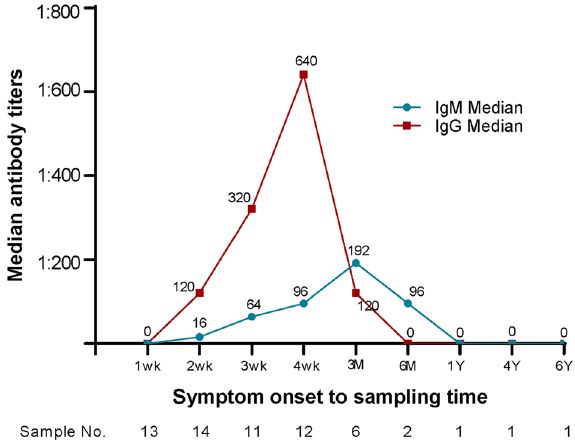
Figure 2. Median antibody titers by symptom onset to sampling time. In the follow-up test on antibody titer initiated from the onset of symptoms, IgG antibody titers increased more rapidly than those of IgM. IgG reached the peak 4 weeks after the onset of symptoms, followed by a decline, and there was no detectable antibody titer after 3 months. IgM reached a peak 3 months from the onset of symptoms, followed by a decline, and there was no detectable antibody titer 1, 4, and 5 years after symptom onset.